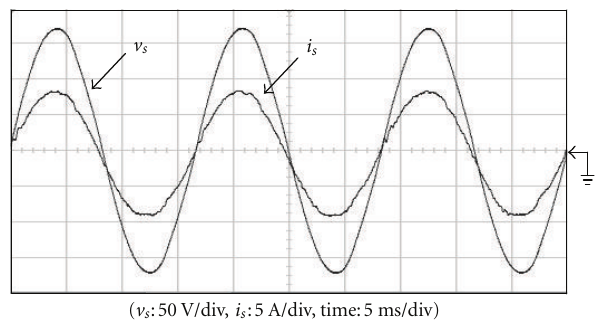
Figure 24: Experimental result: the filtered line current and line voltage during the interval of high